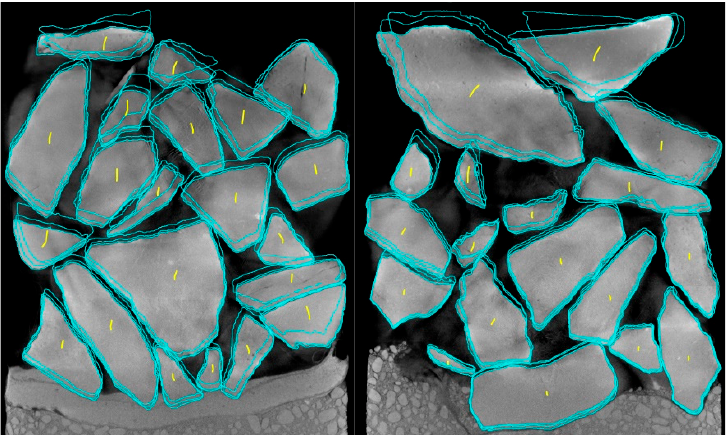
Figure 11. Outline and center-of-mass trajectory of the ballast with CC and without a CC layer ( left and right , respectively).